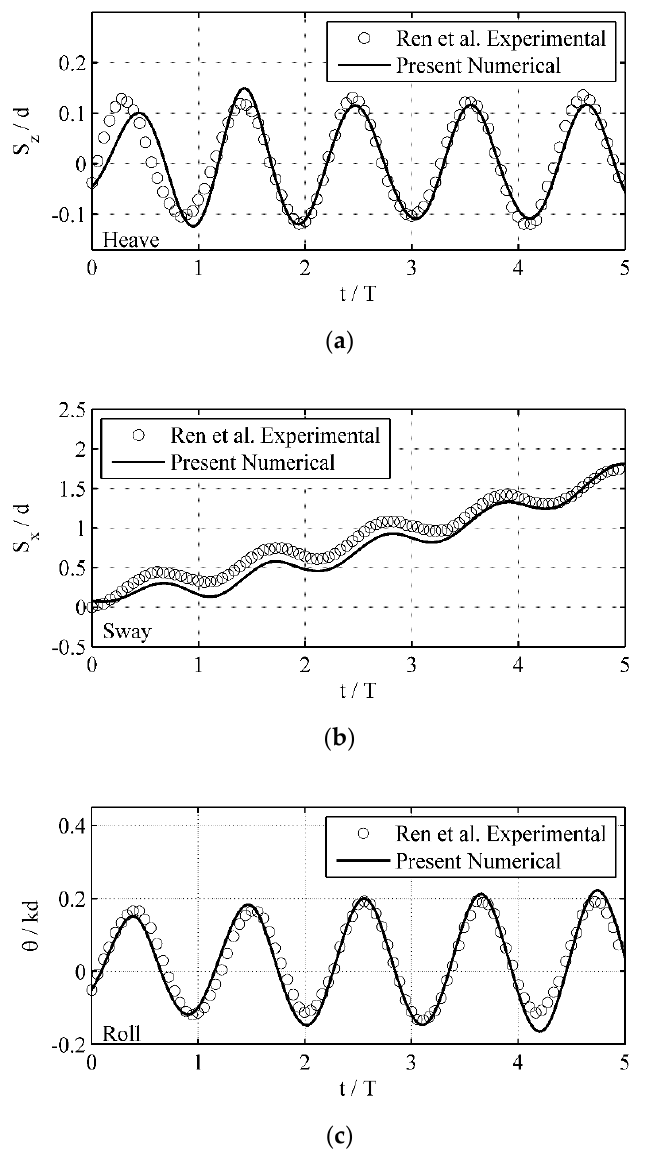
Figure 4. The time sequences of the motions of the floating box under regular waves ( H = 0.1 m); ( a ): heave; ( b ): sway; ( c ): roll.